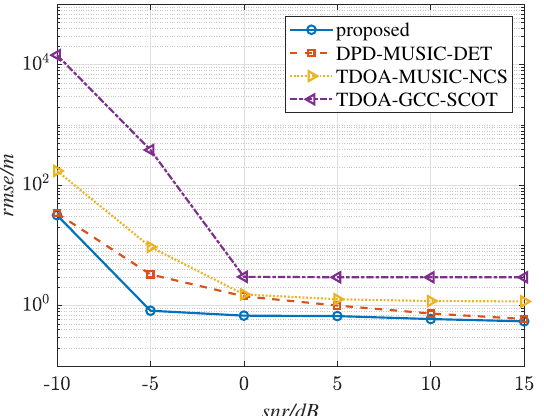
Figure 5. RMSE curves versus SNR in a simulated multipath-free environment ( M = 1 ) .